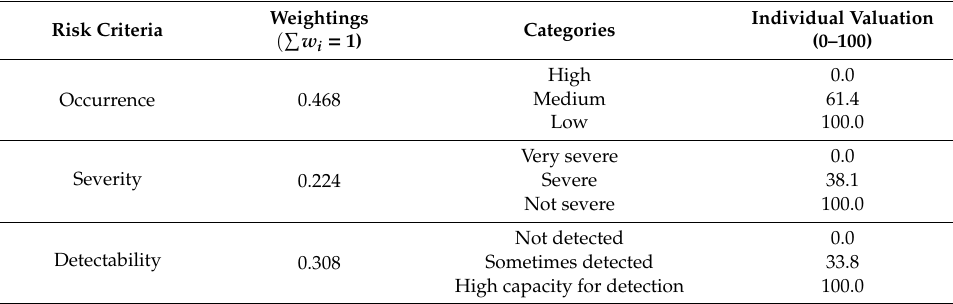
Table 11. Weightings of risk criteria.